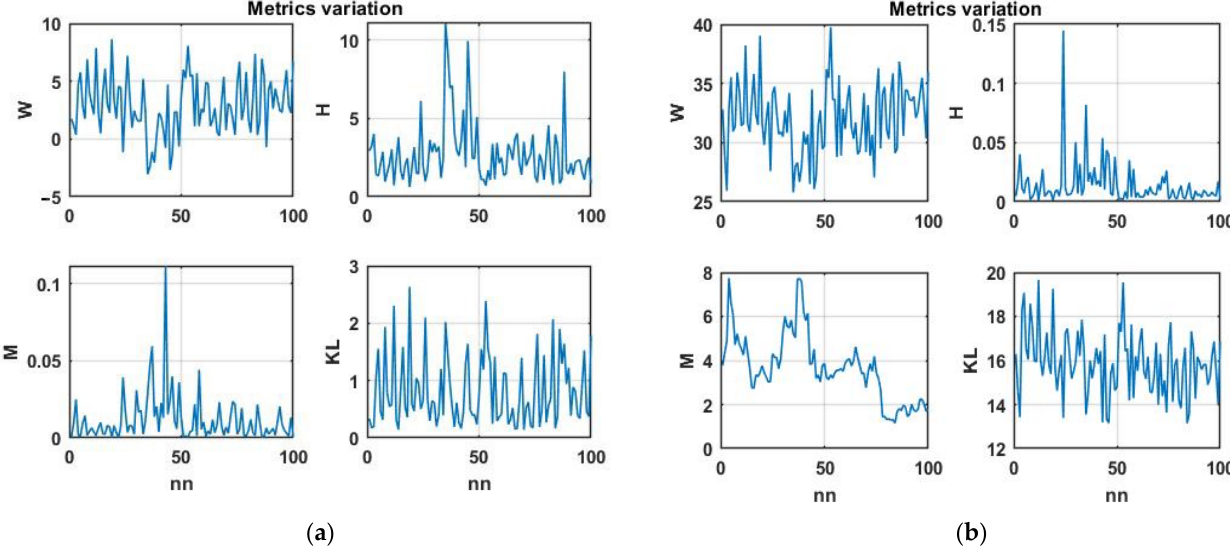
Figure 4. ( a ) Similarity metric variation for the first difference of a multidimensional chaotic process and ( b ) similarity metric variation for a multidimensional chaotic process itself.